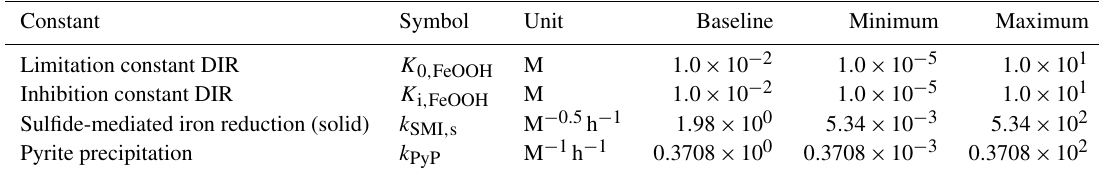
Table 7. Sensitivity range and baseline values of each parameter tested. Note that the units are not identical to the units used in the user configuration files for the cGENIE model. A table with the parameter units converted to cGEnIE units is included in Appendix A. Constant